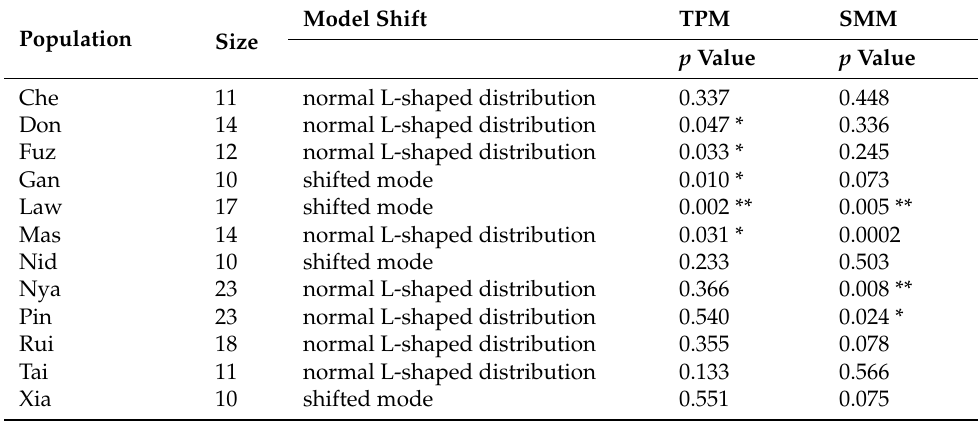
Table 3. Bottleneck test of F. altissima populations with more than ten individual samples.